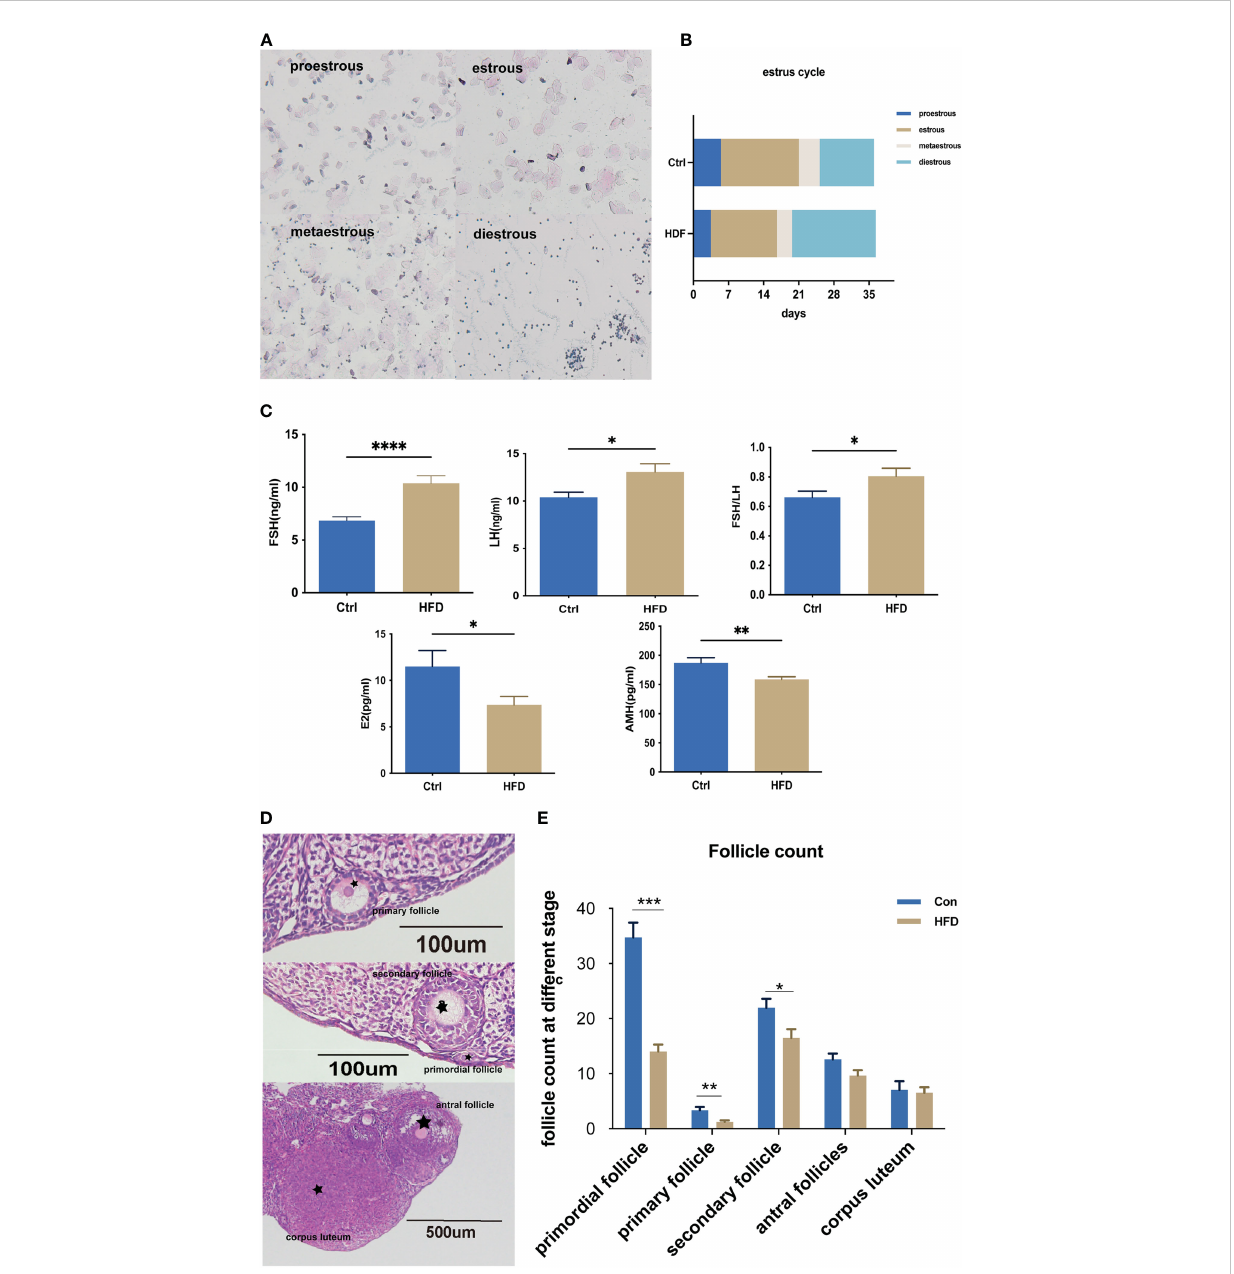
FIGURE 2 HFD induced-insulin resistance decreased the ovarian reserve. (A) Different stages of the estrous cycle were assessed by collecting vaginal smears at the same time point every day. (B) Estrus cycles were assessed every day for the last 5 weeks, n=14 with one repeat in each assay. (C) Serum FSH, LH, E2, and AMH were determined by ELISA; FSH/LH was calculated, n=14 with one repeat in each assay; t-test. (D) Different stages of follicles: primordial follicles; primary follicles, secondary follicles, antral follicles, and corpora lutea. (E) Detailed counting of follicles at different stages, n=14 with one repeat in each assay; t-test. *: P<0.05, **: P<0.01, ***: P<0.001, ****: P<0.0001 compared to group “ Ctrl ”